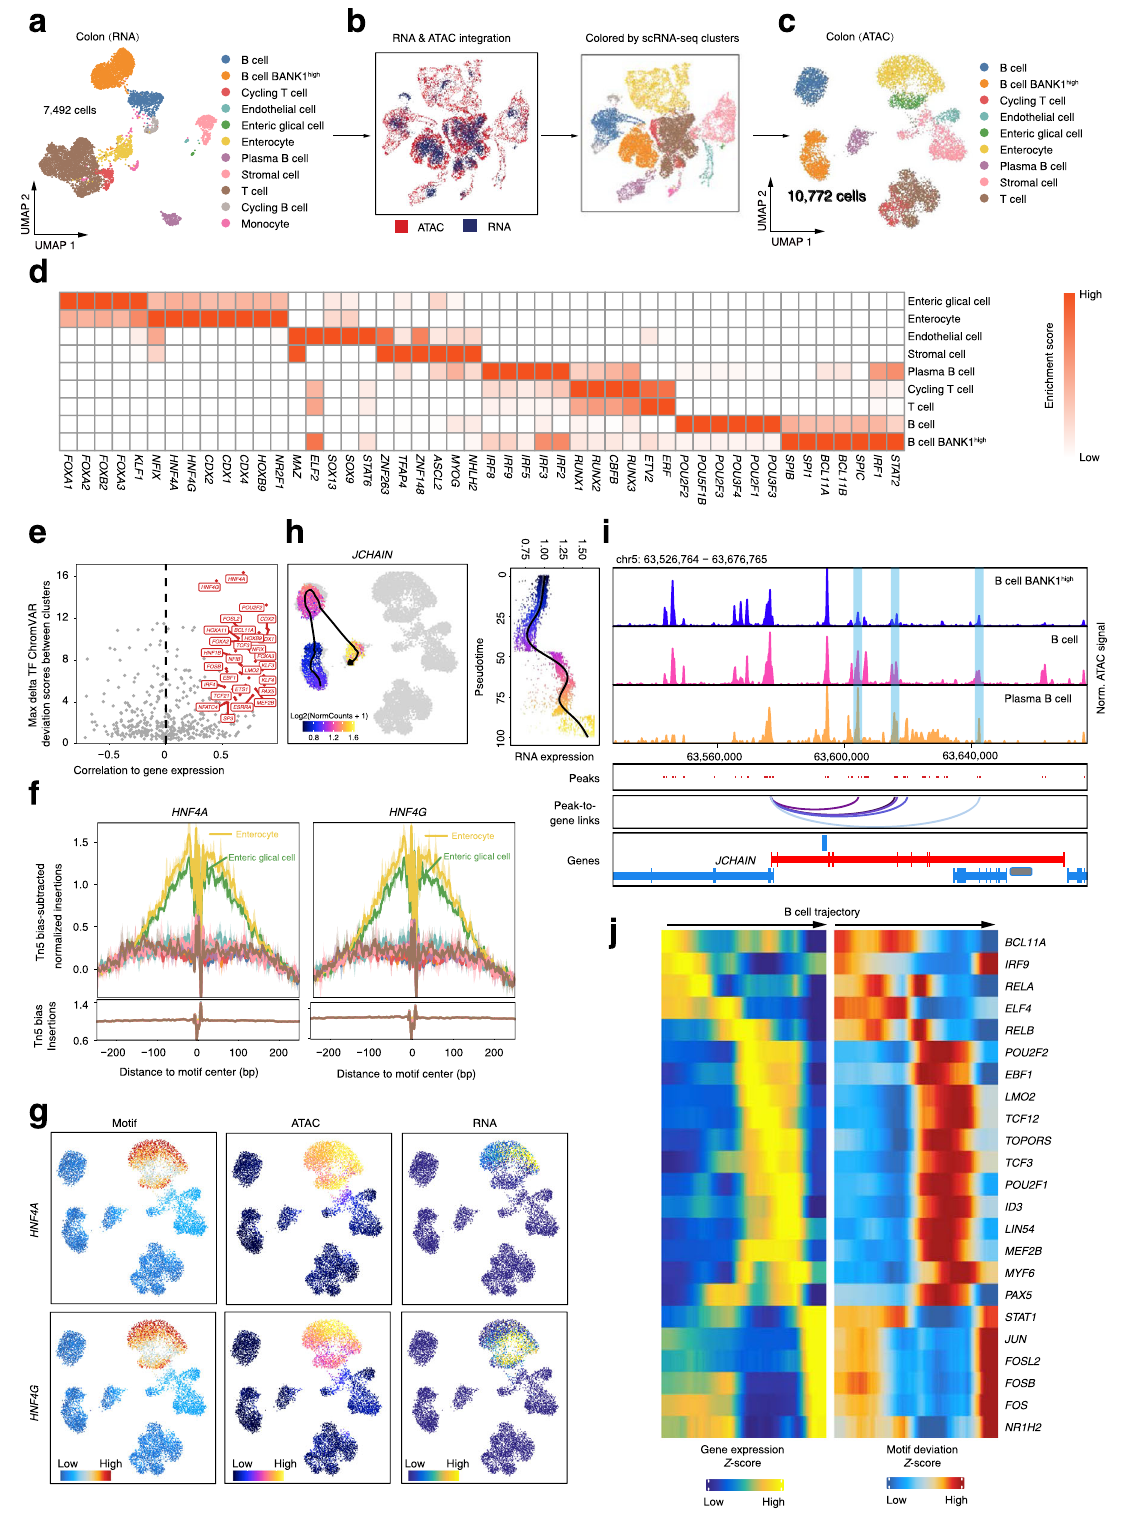
We analyzed the dynamics of gene scores and expression, CRE accessibility as well as TF motif enrichment across the differentia- tion trajectory (Supplementary Fig. 13g). For example, we observed coordinated sequential activation of JCHAIN based on both the gene score and gene expression across the trajectory (Fig.